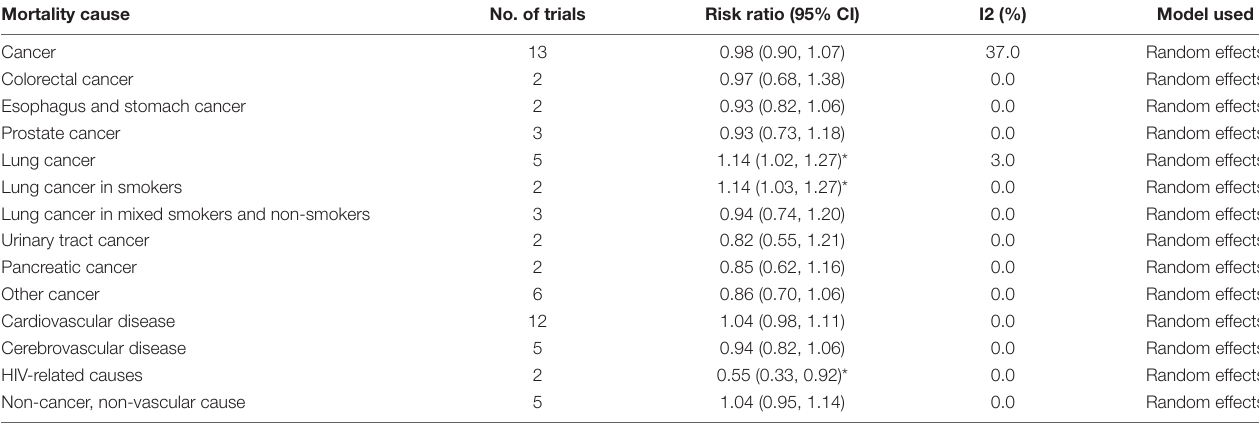
TABLE 4 | Effects of beta-carotene supplements vs. placebo or no intervention on cause-specific mortality. Mortality cause